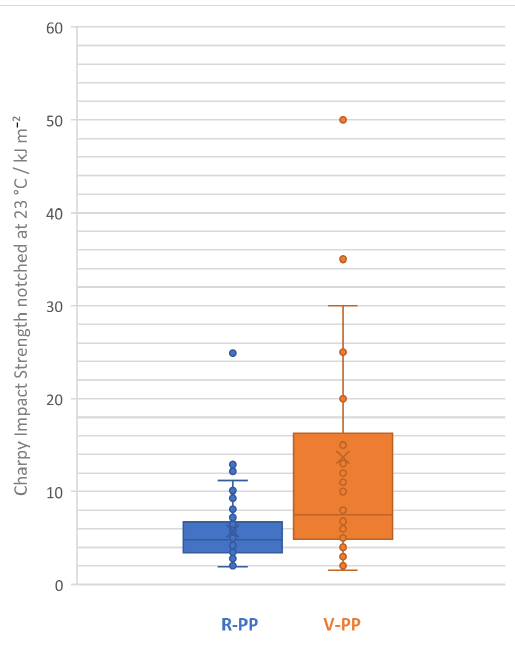
Figure 5. Charpy impact strength of R-PP and V-PP; for data, see Table S2.